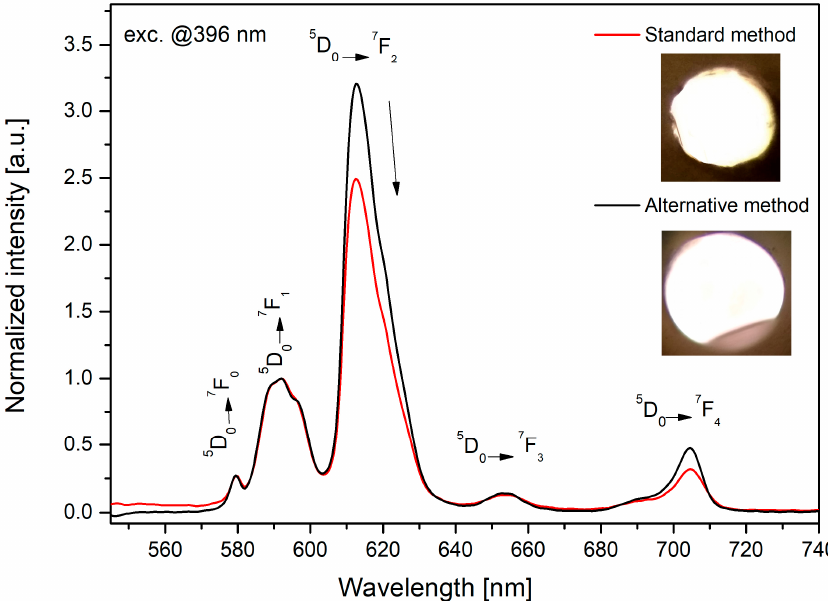
Figure 13. The characteristic of luminescence changes and photos (inset) for 45S5 fibers doped with Eu 3 + drawn by a standard and alternative method.